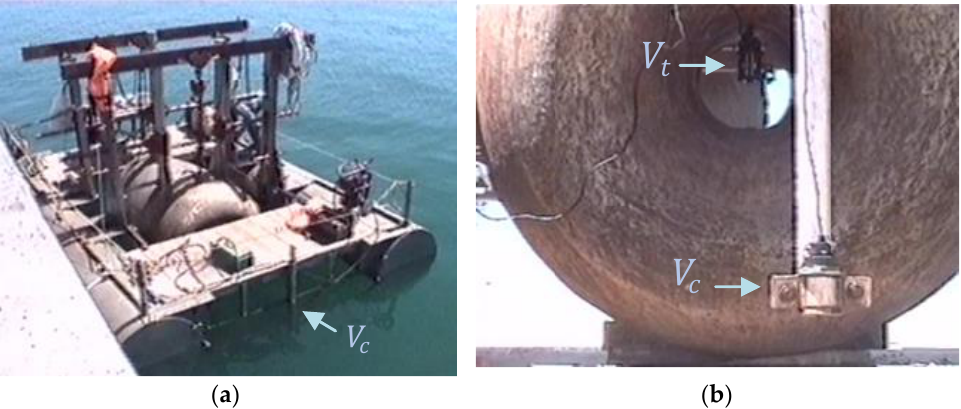
Figure 12. Detail of the water velocity transducer position to measure the raft velocity in relation to the water ( a ); photo of the two water velocity transducers, with the duct scale model D4 the outside water at the higher level ( b ).